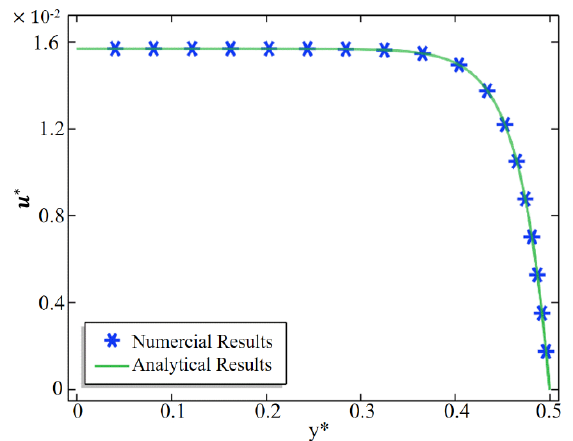
Figure 2. Comparison between the numerical (symbol) and analytical (solid line) results of the axial electroosmotic flow (EOF) velocity in a microchannel.